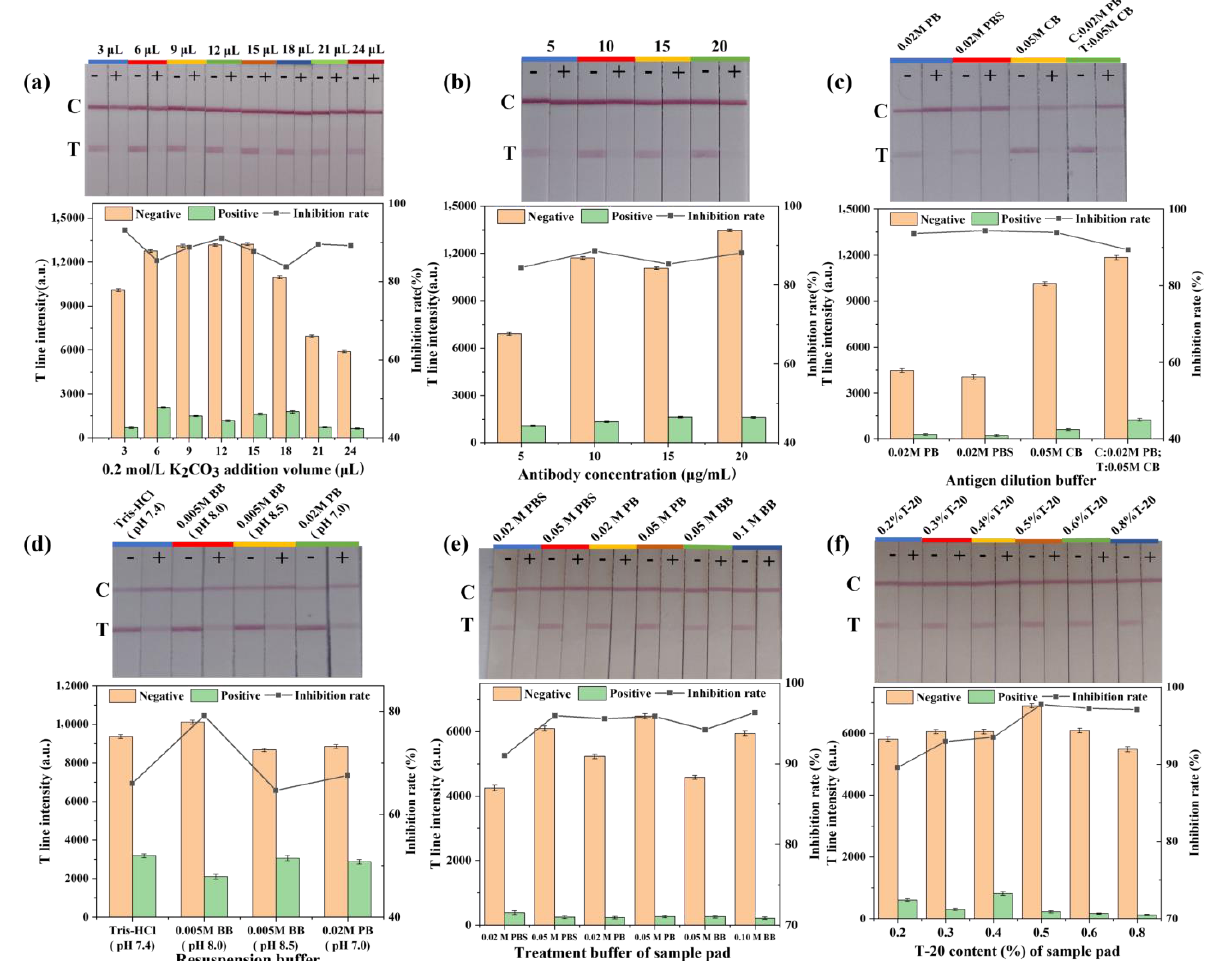
Figure 3. Optimization results of Au nanoparticles lateral flow immunochromatography (AuNPs-LFIA). The LFIA test strip results correspond to the T line intensity obtained by ImageJ software. ( a ) Effect of the pH value represented by 0.2 M K 2 CO 3 volume in 1 mL AuNPs; ( b ) antibody concentration of AuNPs–Abs conjugated probe; ( c ) effect of the dilution buffer of coating antigen and second antibody; ( d ) effect of the resuspension buffer of AuNPs–Abs probe; ( e ) effect of ion type and ion concentration in the sample pad treatment solution; ( f ) effect of Tween-20 content in the sample pad treatment solution. − , Negative; +,